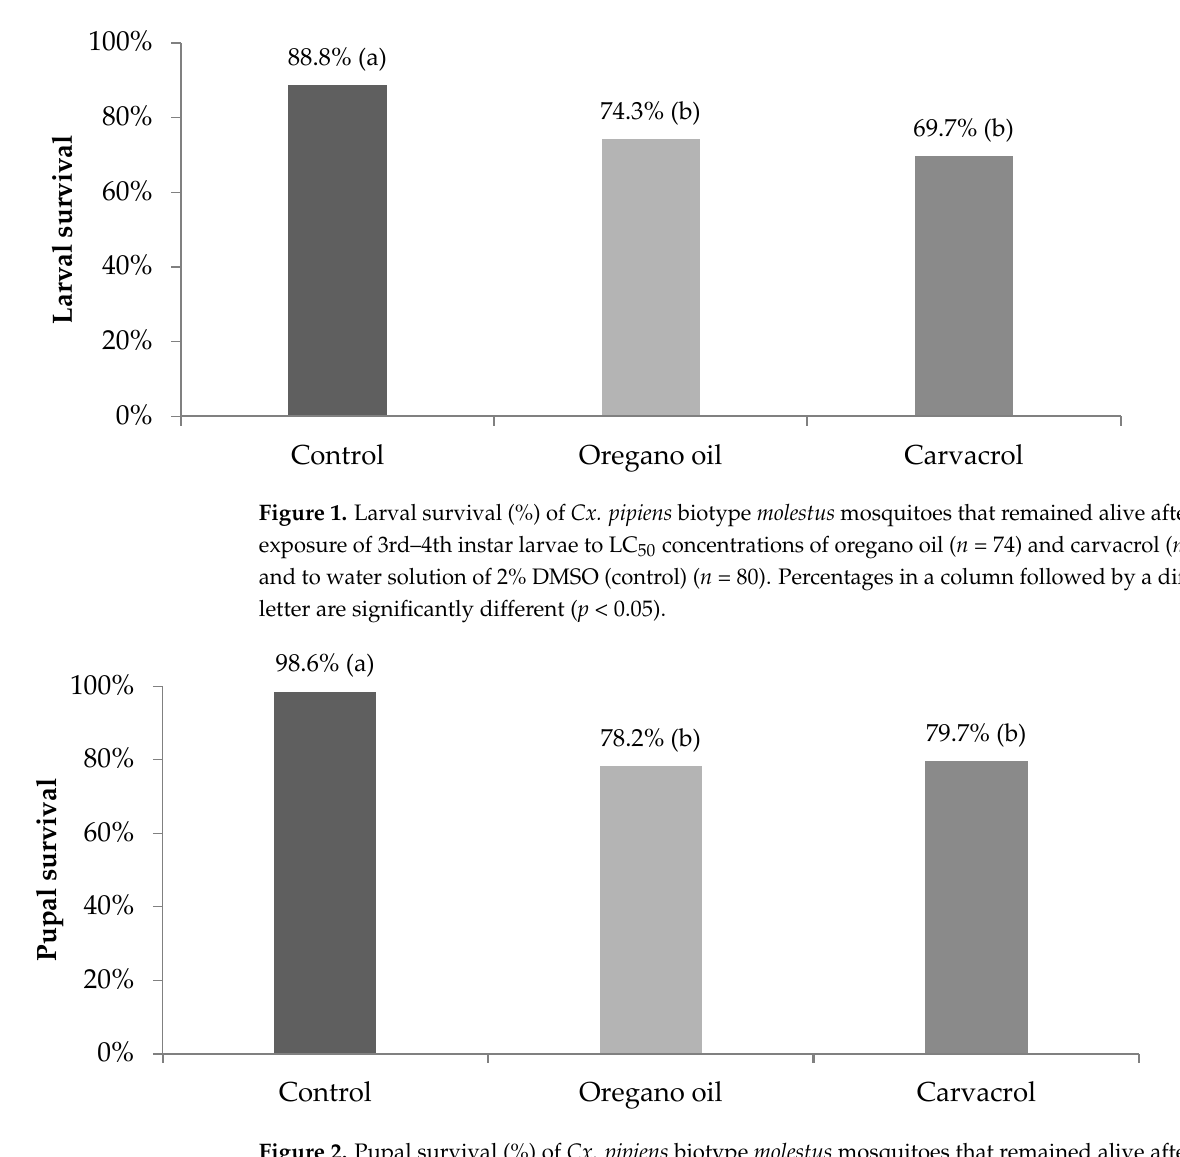
Figure 3. S urvival (%) until adulthood of Cx. pipiens biotype molestus mosquitoes that remained alive after 24 h exposure of 3rd–4th instar larvae to LC 50 concentrations of oregano oil ( n = 74) and car- vacrol ( n = 99), and to water solution of 2% DMSO (control) ( n = 80). Percentages in a column fol- lowed by a di ff erent le tt er are signi fi cantly di ff erent ( p < 0.05). Interesting morphological abnormalities were observed in some cases after exposing larvae to LC 50 concentrations of oregano oil or carvacrol: elongated dead larvae, larviform dead pupae being partially melanized or demelanized, and adults that failed to emerge properly and died on the water surface. Occasionally, only the head and thorax emerged from the puparium, or the adults were still a tt ached to the puparium by one or more legs (Figure 4).